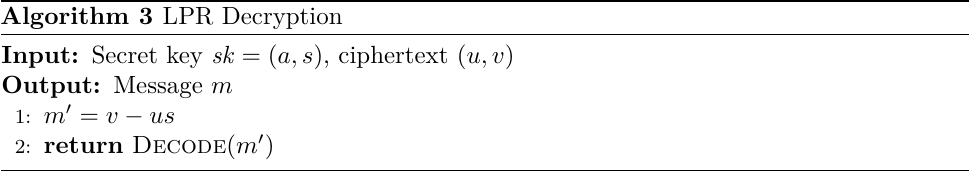
Algorithm 3 LPR Decryption